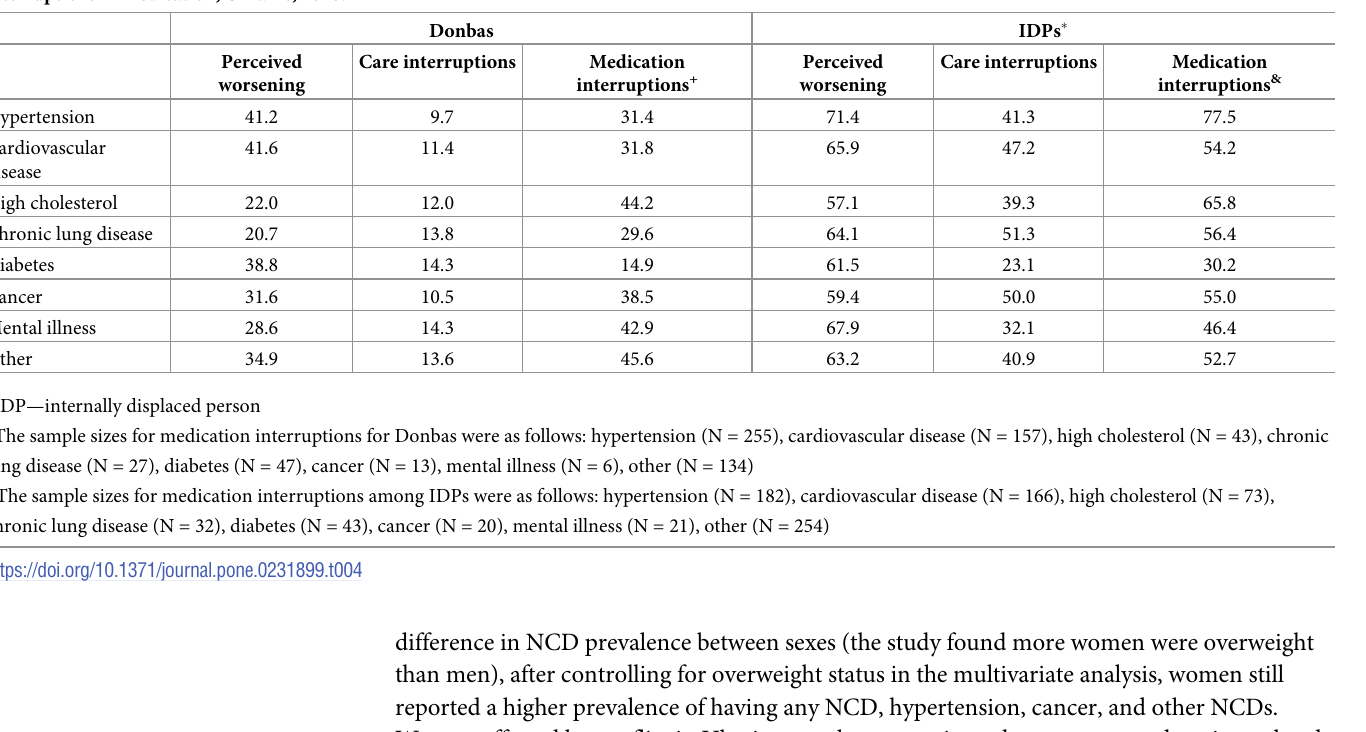
Table 4. Proportion of conflict-affected adults reporting perceived worsening of noncommunicable disease, experienced interruptions in care, and experienced interruptions in medication, Ukraine, 2018.